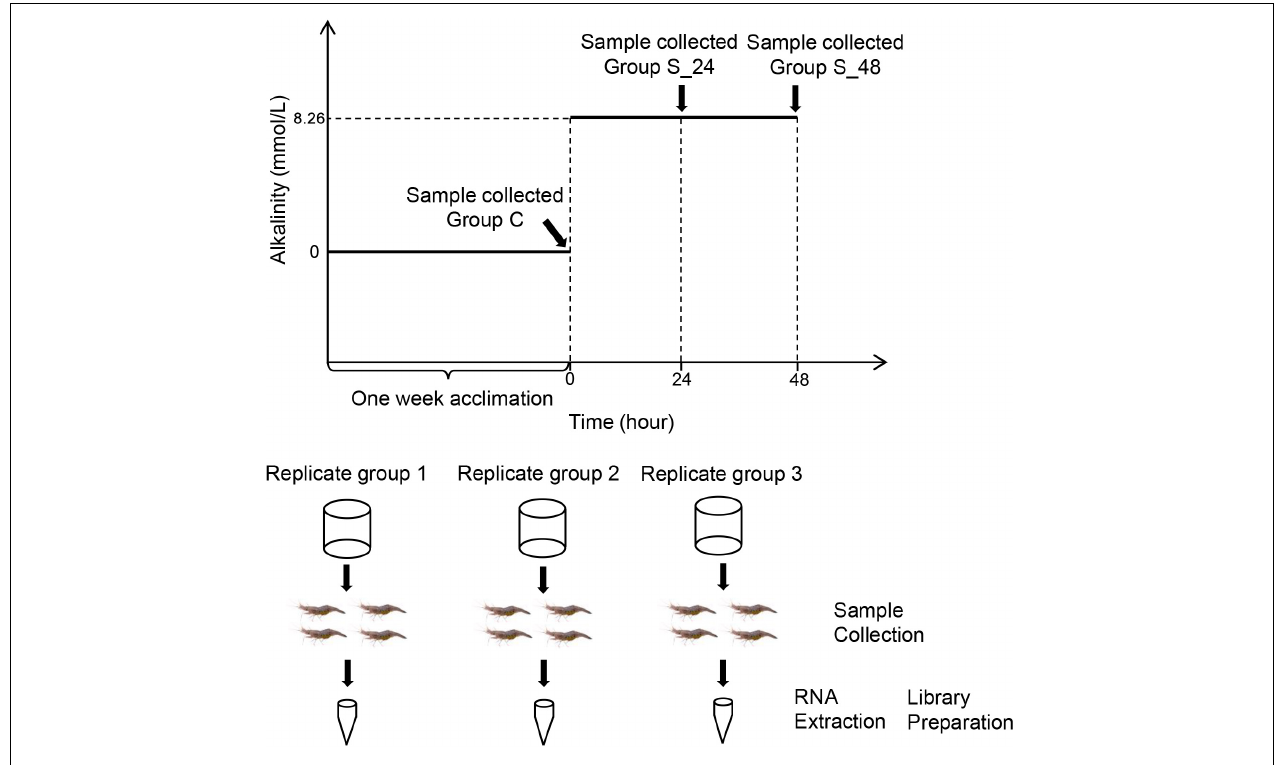
FIGURE 1 | Schematic representation of the acute saline-alkali stress experiment and sample collection, the saline-alkali stress concentration as 10 mmol/L. Samples were collected before the experiment (control group), at 24 h (24 h of saline-alkali stress), and at 48 h (48 h of saline-alkali stress).